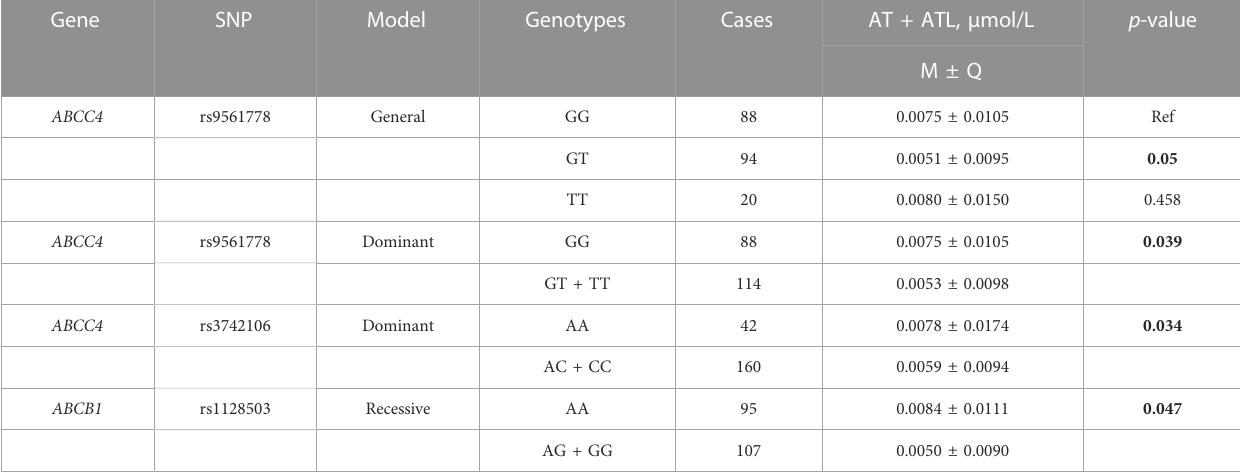
TABLE 3 Association between SNPs and plasma concentrations of AT +